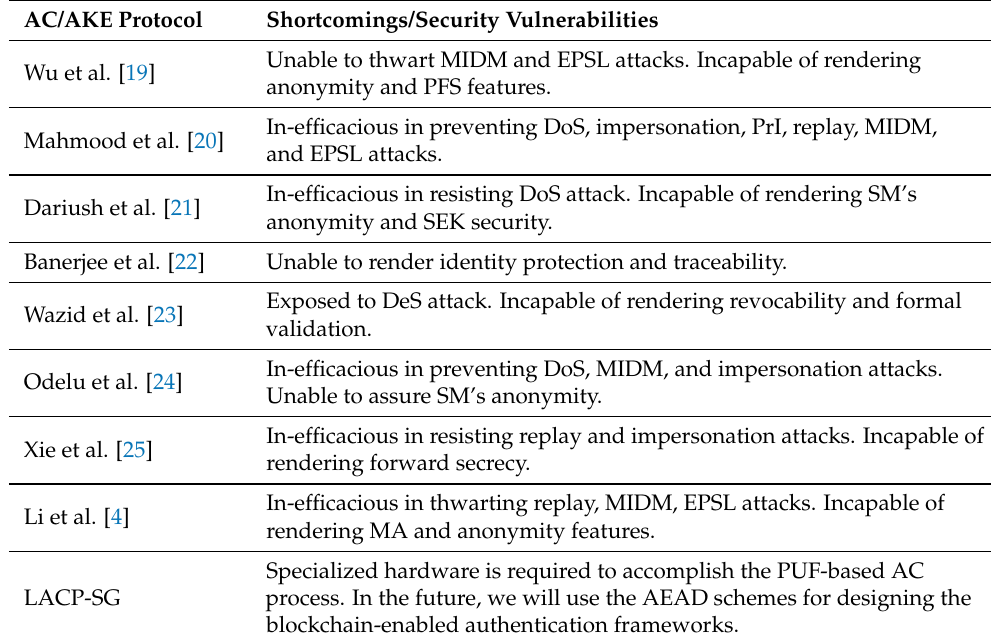
Table 1. Summary of various AC